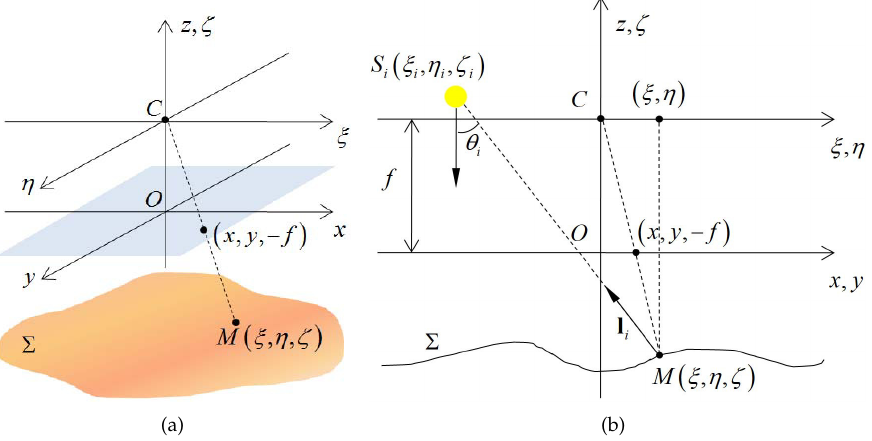
Figure 3. Photometric stereo framework. ( a ) Pinhole camera model of the endoscopic camera. ( b ) Near point light source model of the surface-mounted